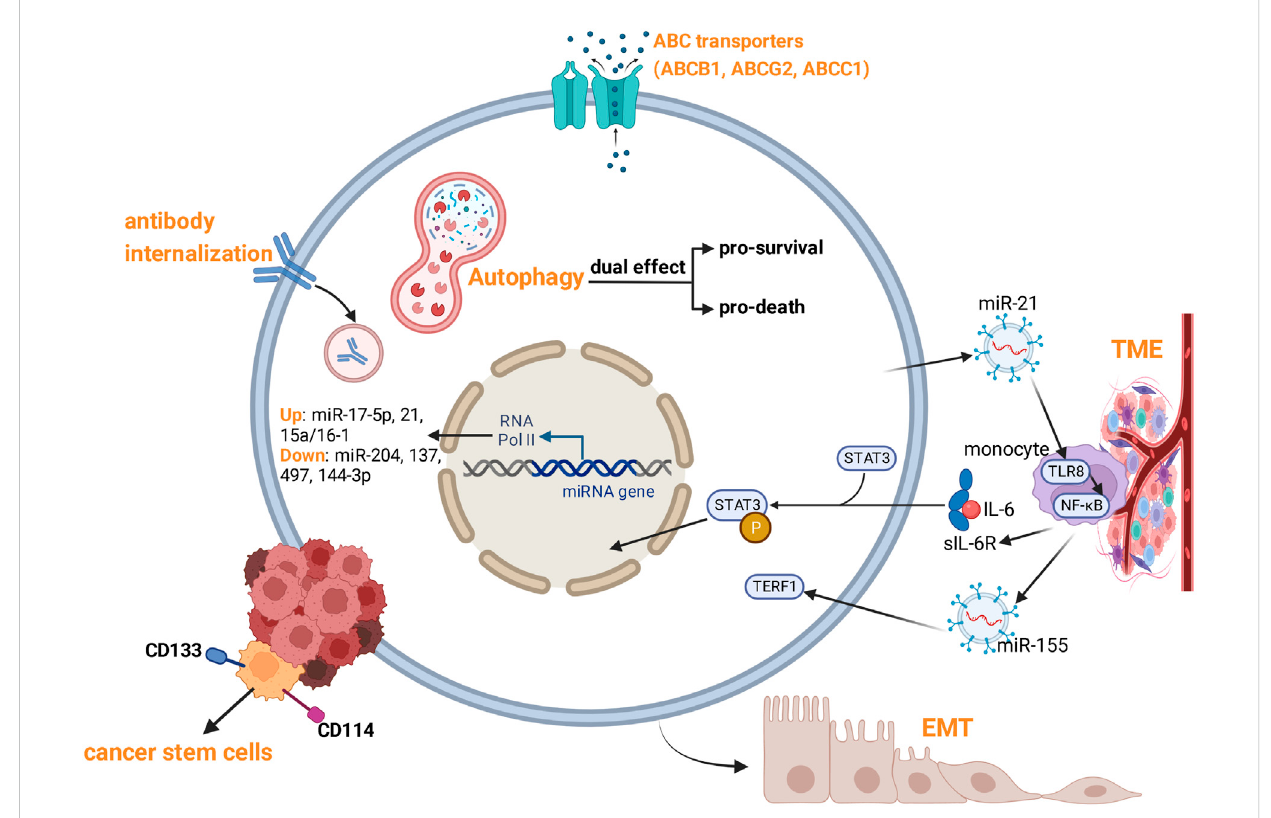
FIGURE 2 Mechanisms of therapy resistance of